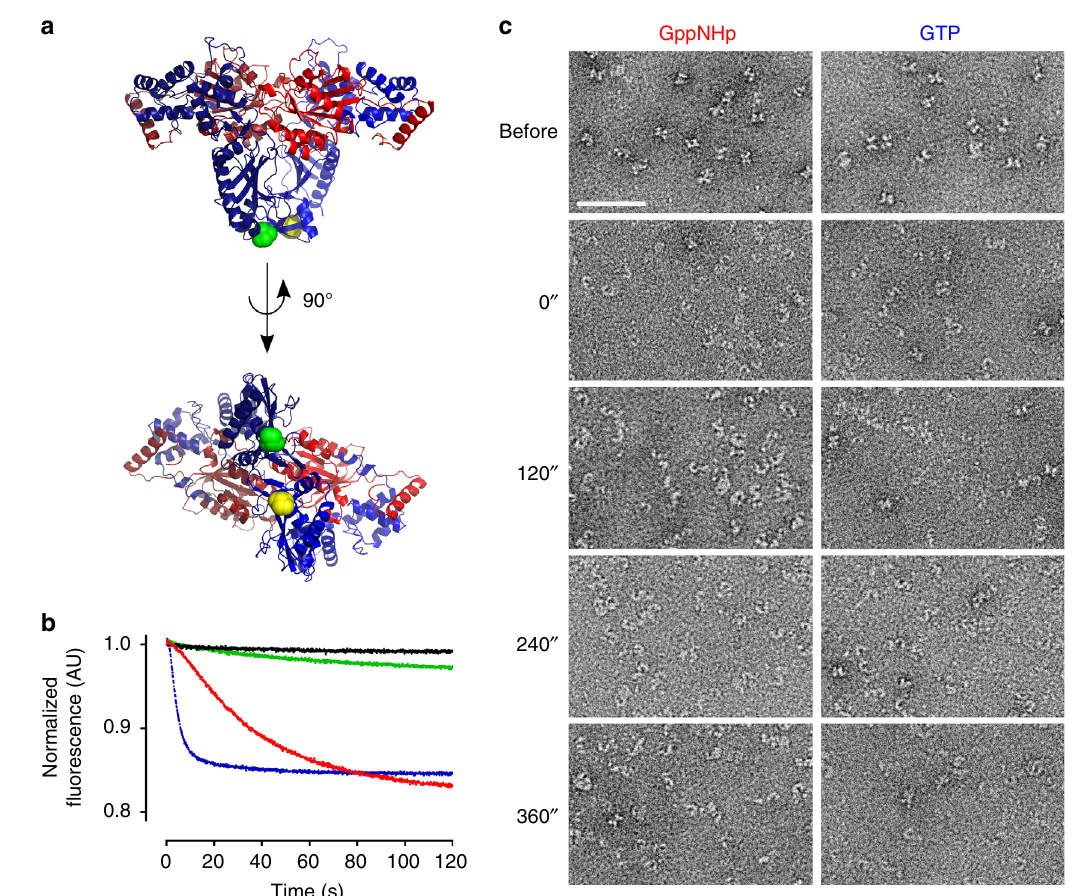
Fig. 3 GppNHp- and GTP-induced monomerization of the Chlorobium tepidum Roco protein occurs in a time scale relevant for GTP turnover. a Two different views of the dimeric CtRoc-COR crystal structure with amino acid 928 colored green and yellow for protomer A and B, respectively. Within the dimeric protein these residues are separated by a distance of 20 Å allowing them to be used for Cy3/Cy5 FRET experiments. The Roc and COR domains are colored red and blue (dark for protomer A and light for protomer B), respectively. b Stopped- fl ow FRET traces of labelled CtRoc-COR upon mixing with different nucleotides to follow monomerization in time. The FRET signal of Cy3/Cy5-labeled CtRoc-COR (S928C) over time is shown after rapid mixing with buffer ( black ), or 50 µ M GDP ( green ), GppNHp ( red ) or GTP ( blue ). c Monomerization of CtRoco followed via time-resolved negative stain EM. CtRoco was mixed with 1 mM of GppNHp or GTP and samples were taken every 2 min. Representative EM images of the samples just before adding nucleotide and for each time point are shown. ( scale bar : 50